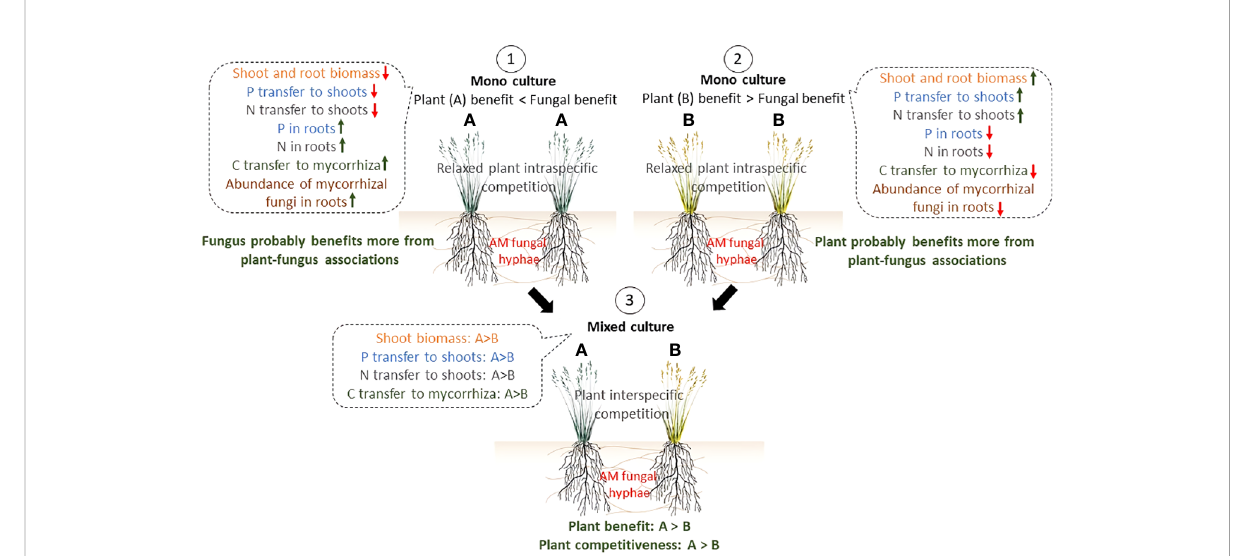
FIGURE 7 A conceptual model of interactions between a single AM fungal taxon and coexisting plants (A, B) , relevant to experimental results presented here. Bene fi ts from a plant perspective were de fi ned in terms of biomass and nutrient accumulation in aboveground plant tissues. In Scenario